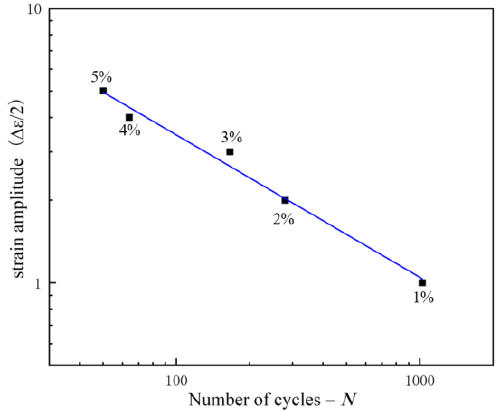
Figure 9. Fatigue life at different strain amplitude.